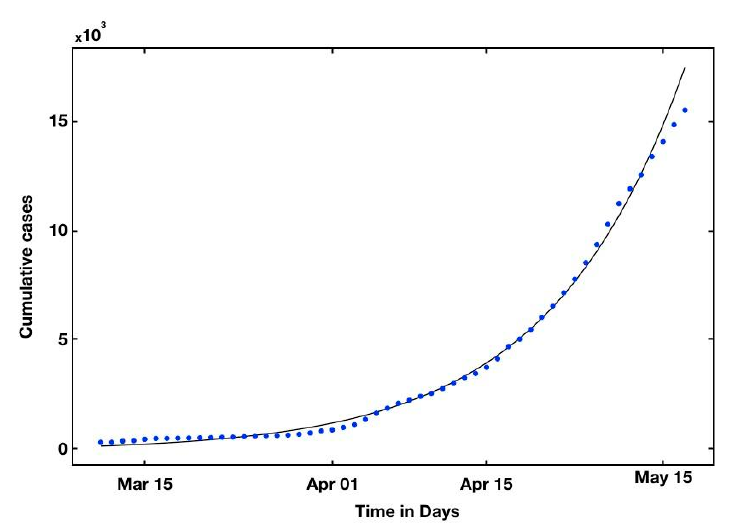
Figure 3. We plot the simulated number of t → C(t) (black line) and the data corresponding to the confirmed cumulative reported cases between 11 March and 16 May (blue dotted) in Qatar. The dots correspond to t → C(t), where C(t) is taken from the cumulated confirmed cases in Table 3 (top).